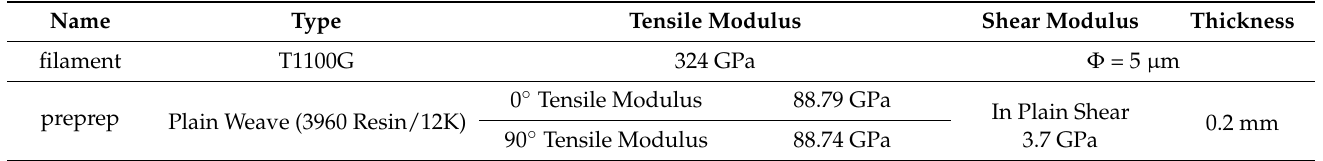
Table 1. The parameters of Toray ® T1100G carbon fiber and prepreg [45].